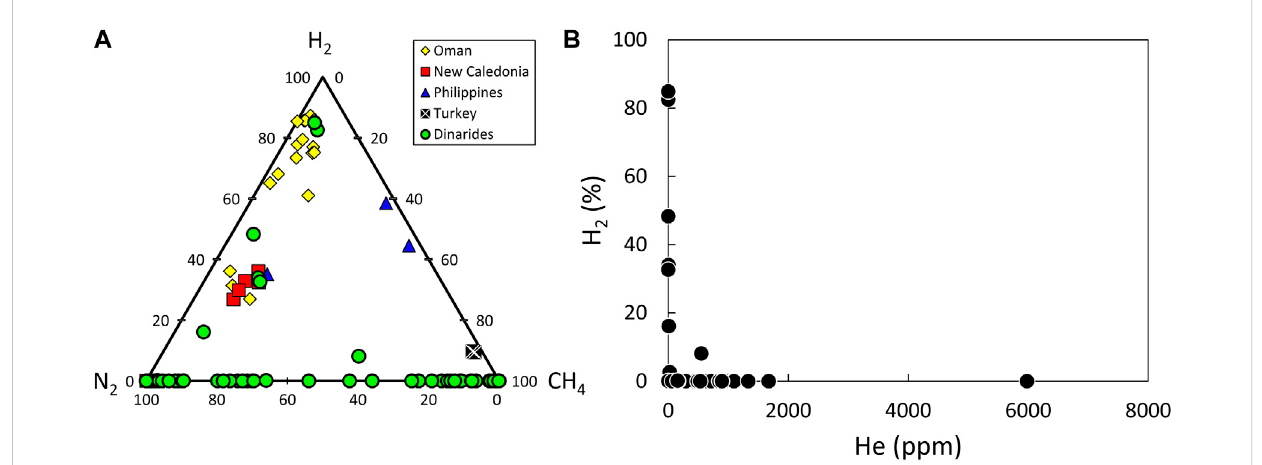
Compilation of gas compositions in the Dinarides represented in (A) ternary diagram of H 2 – N 2 – CH 4 in addition to gas compositions in Oman, New Caledonia, The Philippines, and Turkey (Vacquand et al., 2018) and plotted in (B) graph of H 2 content against He content.